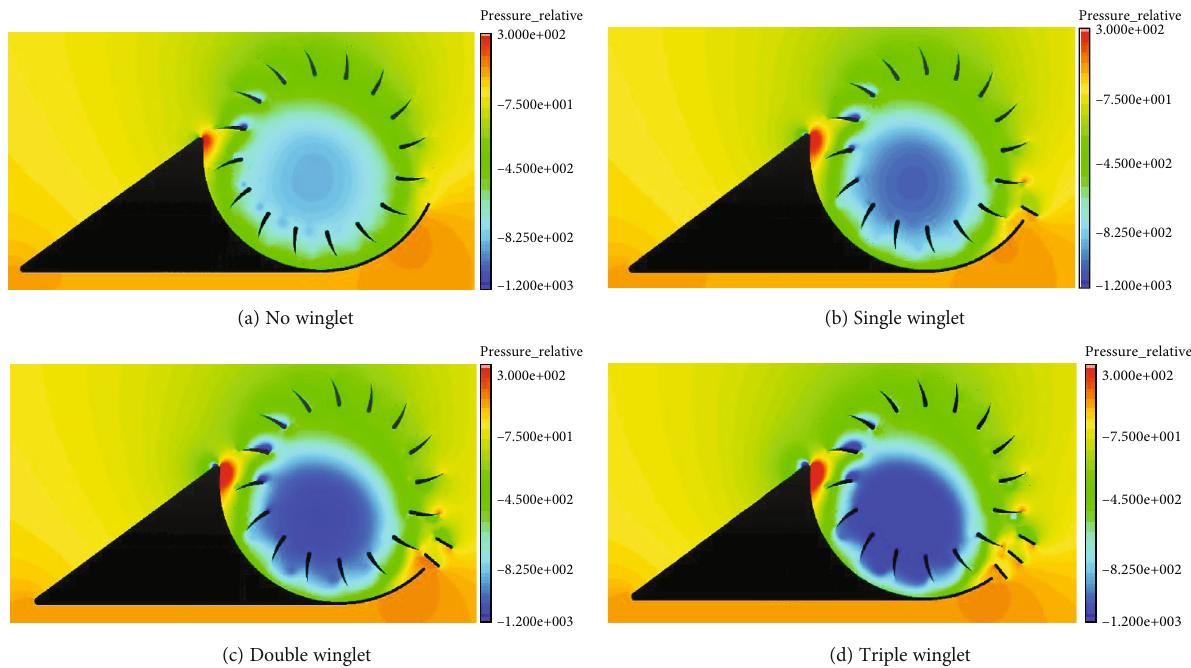
Figure 21: Pressure nephogram of di ff erent number leading edge winglet ( Installation angle = 90 ° , v = 12 m/s, α = 0 °